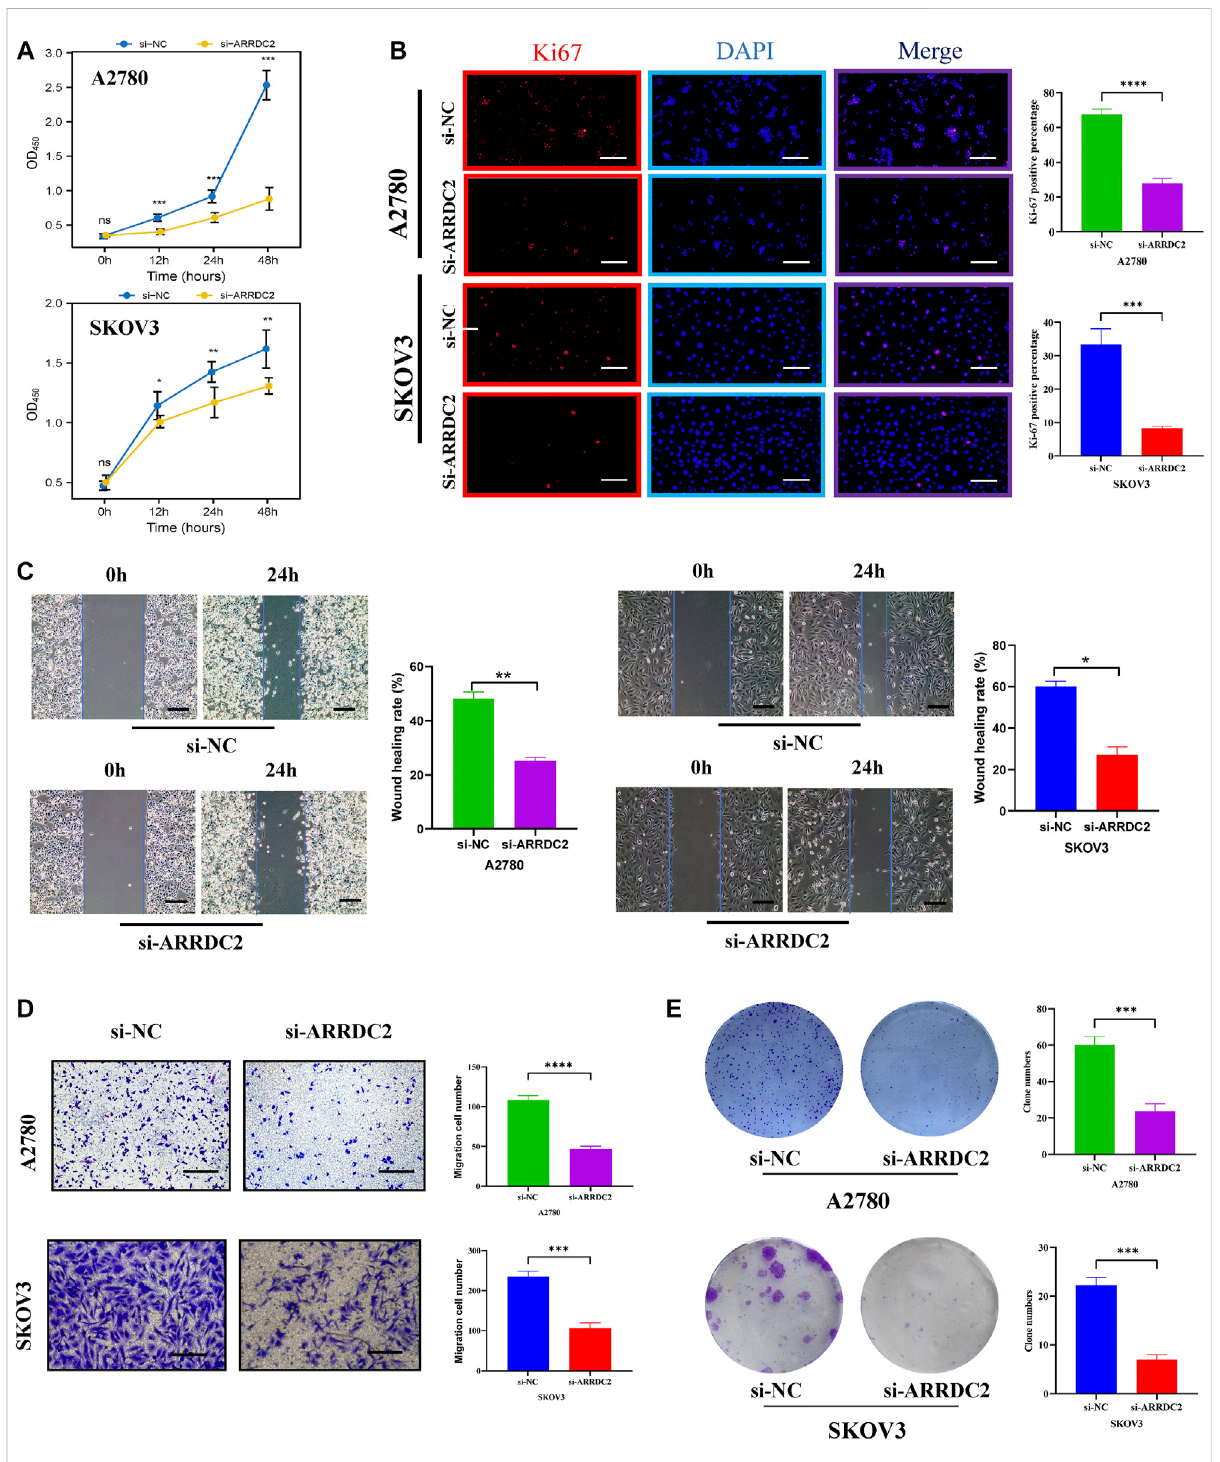
FIGURE 9 Effects of ARRDC2 gene knockdown on malignant biological behavior of OC cells. (A) CCK8 experiment results of A2780 and SKOV3 cell lines after cell transfection. The ODvalues measuredat450 nm wavelengthat0, 12,24, and 48 hweredisplayed,whichrepresented thecell proliferation rate. (B) Ki-67 immuno fl uorescence staining of A2780 and SKOV3 cell lines after cell transfection. (C) Wound-healing assay results and statistics of OC cells after cell transfection. The wound-healing rate was measured at 0 and 24 h. (D) Transwell assay results and statistics of OC cells after cell transfection. The number of migrating cells was measured at 24 h, which represented the ability to migrate. (E) The results and statistics of cell clone formation assay of A2780 and SKOV3 cell lines after cell transfection (* p < 0.05, ** p < 0.01, *** p < 0.001, **** p <